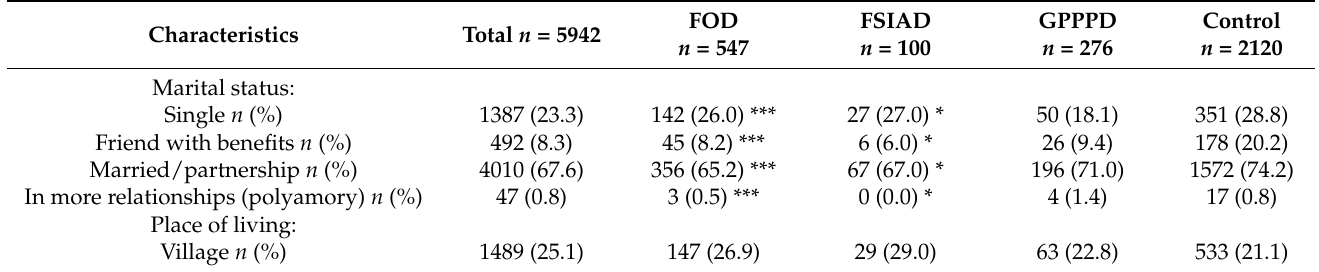
Table 1. Characteristics of the